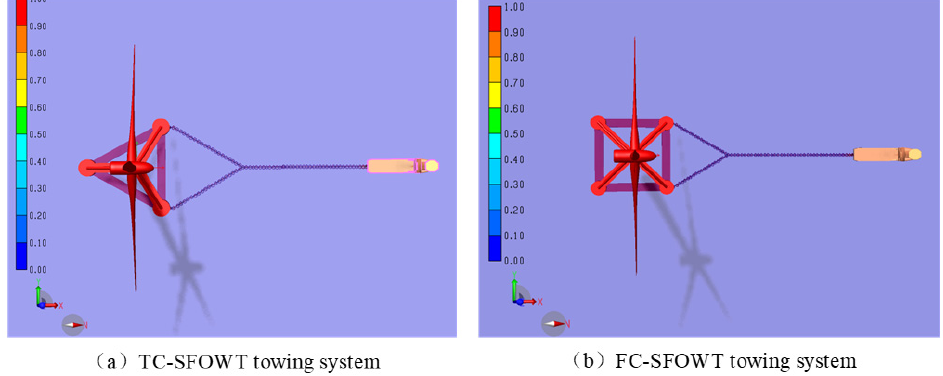
Figure 3. Bird’s eye view of the TC-SFOWT and FC-SFOWT towing system.